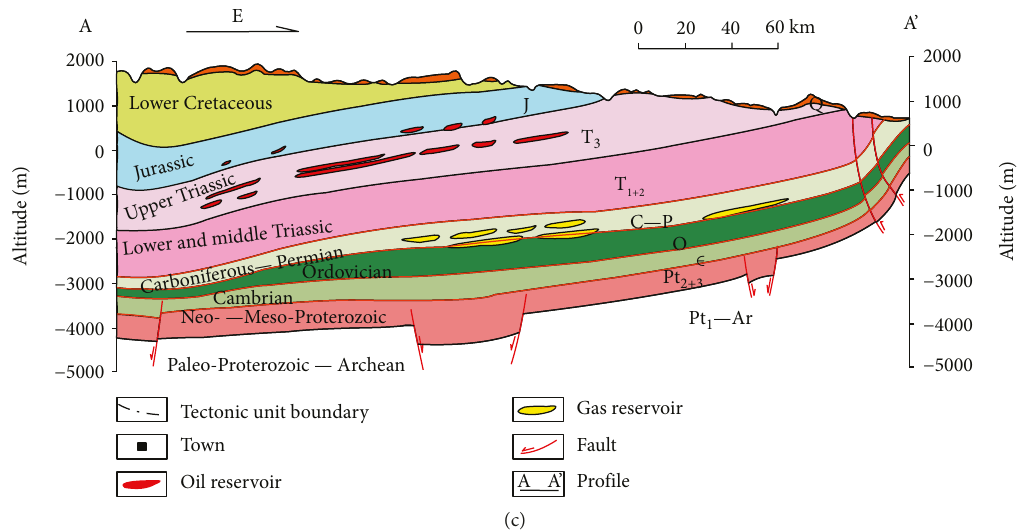
Figure 1: (a) Maturity map of the upper Paleozoic strata of the Ordos Basin, with sample locations labelled by well name (after [16]); (b) stratigraphic column of the Paleozoic strata of the Ordos Basin (after [16]); (c) cross section for Ordos Basin (after